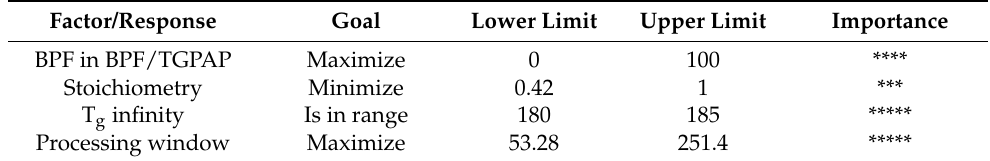
Table 5. Criteria for epoxy blend optimization (a greater number of * indicate that a higher importance was placed on that particular response or